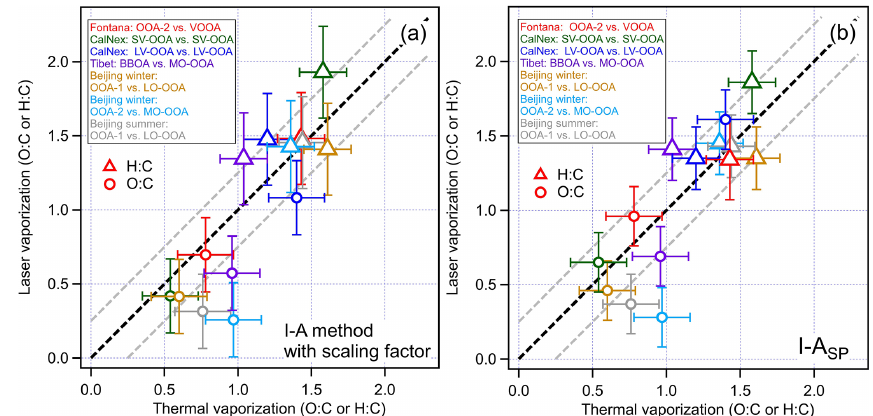
Figure 6. Comparisons between ambient OOA data measured by co-located SP-AMSs and HR-ToF-AMSs in the Nexus of Air Quality and Climate Change (CalNex) 2010 campaign (Massoli et al., 2015); Fontana, California, in 2015 (Chen et al., 2018; Lee et al., 2017); Tibet in 2015 (Wang et al., 2017; Xu et al., 2018); and Beijing in 2016 (Wang et al., 2019; Xie et al., 2019b) and 2017 (Wang et al., 2020; Xie et al., 2019a; Xu et al., 2019) (see Table S1 for the detail of ambient data comparison). For (a) , the H : C and O : C ratios determined by the laser vaporization approached were corrected by the LV elemental analysis scaling factors (1.10 for H : C and 0.89 for O : C). For (b) , the H : C and O : C ratios were determined using the I-A SP method. The LV scheme of the SP-AMS was used to detect rBC-containing particles exclusively. The error bar represents the average absolute errors of I-A (TV in a and b , and LV in a ) and I-A SP (LV in b ) for determining the H : C and O : C ratios. The dashed black line represents the 1 : 1 line and the dashed grey line indicates ± 0.25 of 1 : 1